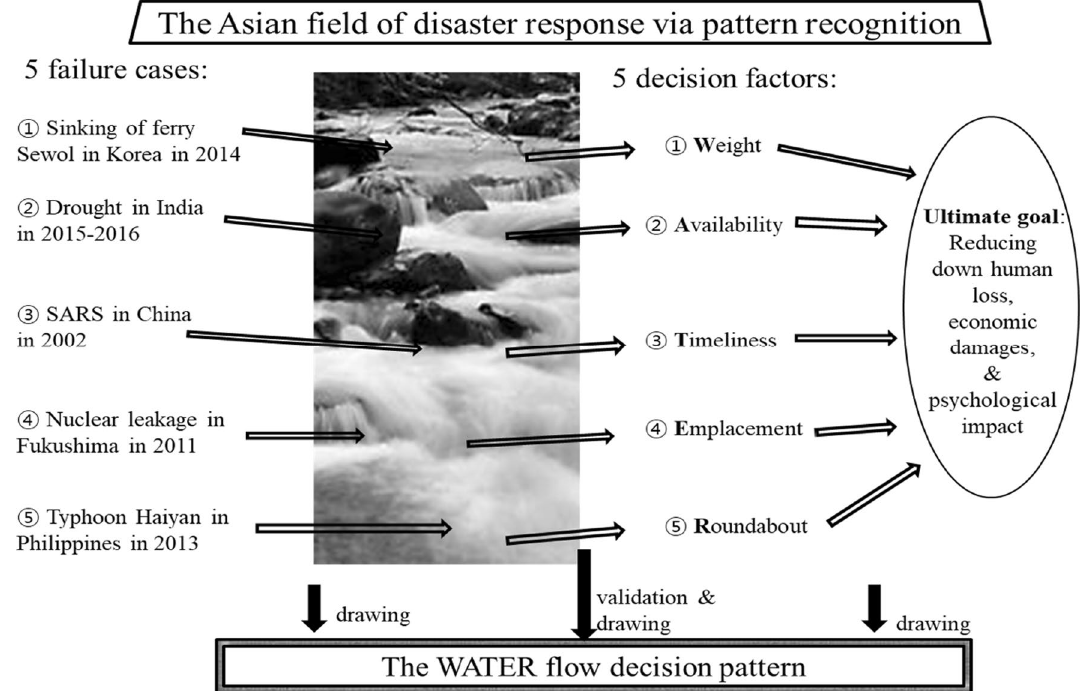
Fig. 1 Water flow decision